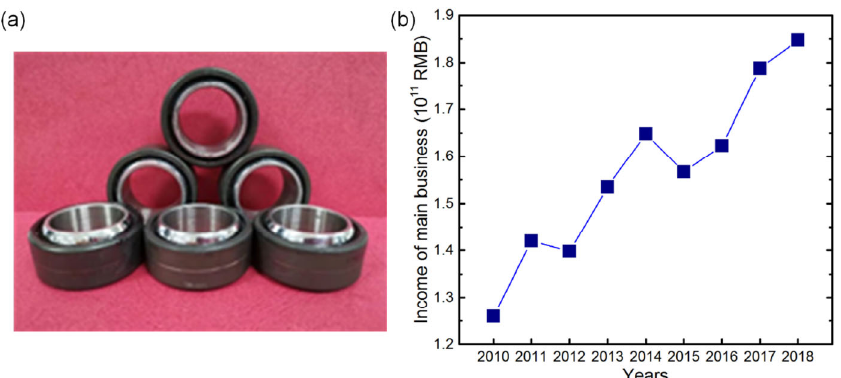
Fig. 9 (a) Solid lubricated joint bearing and (b) income of principal bearing companies above the designated scale in China from 2010 to 2018.